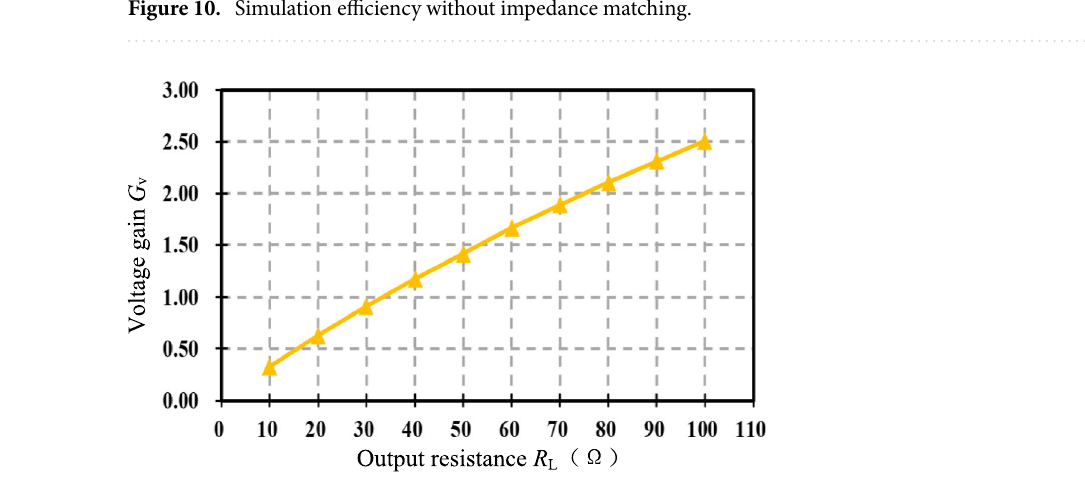
Figure 11. Variation of resonator voltage gain with load